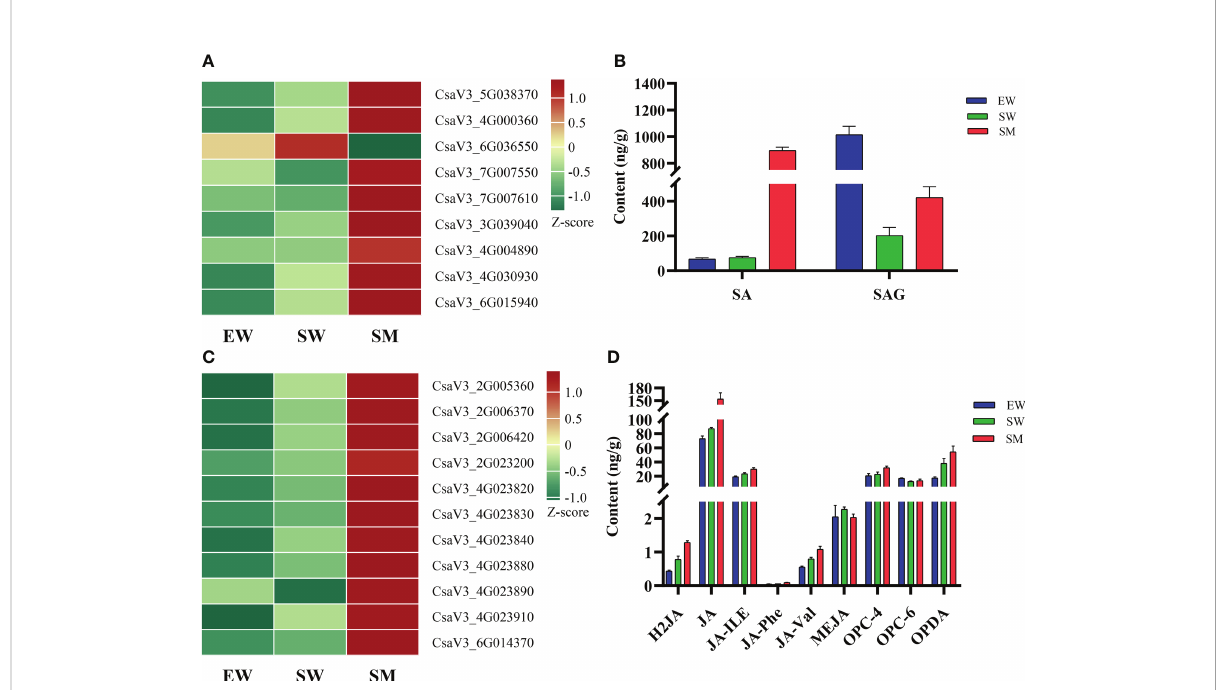
FIGURE 5 Effects of melatonin on genes and hormones related to salicylic acid and jasmonic acid in cucumber seedings. (A, B) Effects of melatonin on the expression of salicylic acid-related genes and salicylic acid content. (C, D) Effects of melatonin on the expression of jasmonic acid-related genes and jasmonic acid content. EW (hypocotyl exposed and irrigated with water), SW (hypocotyl shaded and irrigated with water) and SM (hypocotyl shaded and irrigated with 100 µM melatonin).